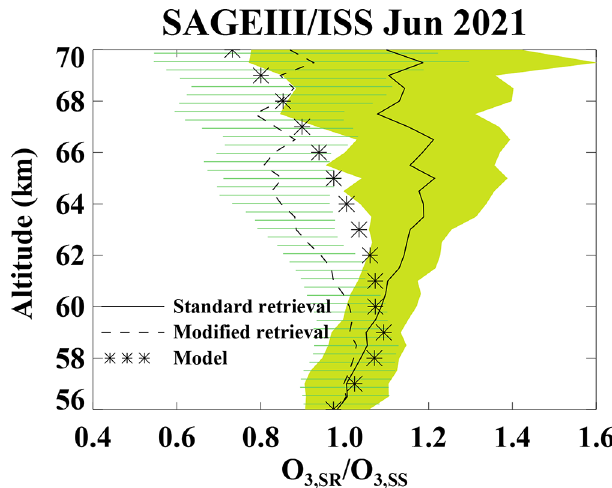
Figure 14. Vertical profile of O 3 sunrise to sunset ratio in June 2021. Nearly collocated 10 pairs of sunrise (mean latitude 10.46 ◦ S) and sunset (mean latitude 10.27 ◦ S) data are used for this plot. Solid line shows the mean ratio from standard (archived) retrieval and the green shade represents the standard deviation; dashed line shows the mean ratio from the retrieval including diurnal variations along the LOS and the horizontal lines represent the standard deviation. The asterisk symbols are the ratios from diurnal photochemical cal- culations at 11.25 ◦ S for